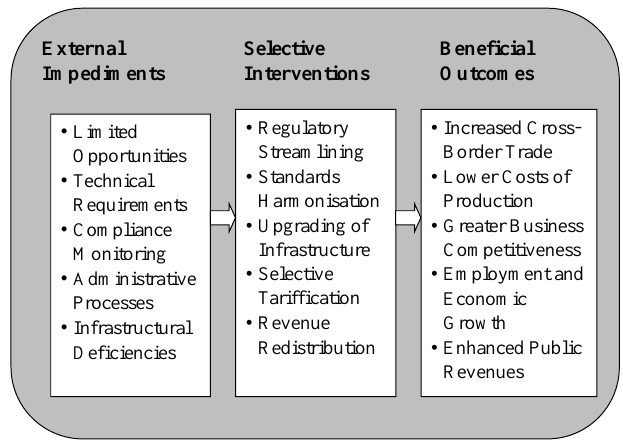
Figure 3: Southern African trade - challenges